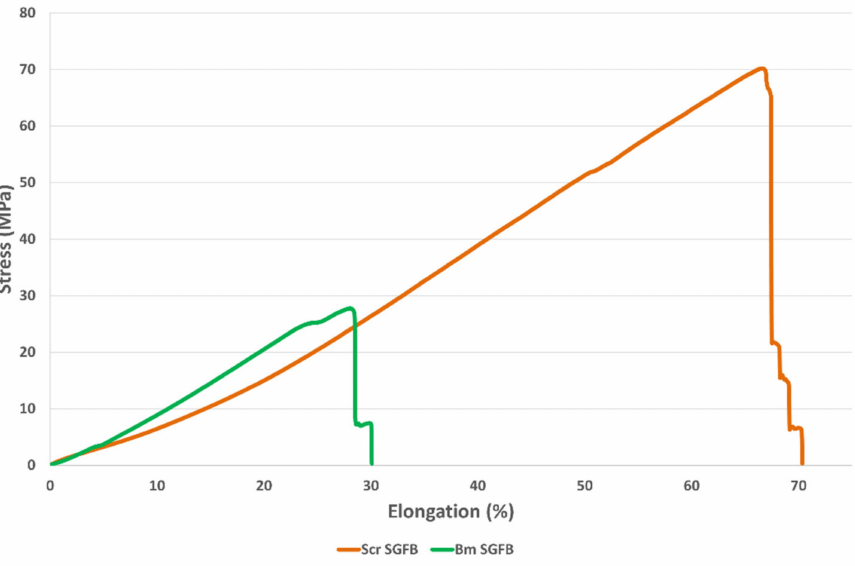
Figure 4. Stress–strain curves obtained during tensile tests of braided scaffolds manufactured from silk glands of S. c. ricini (Scr SGFB) and from B. mori (Bm